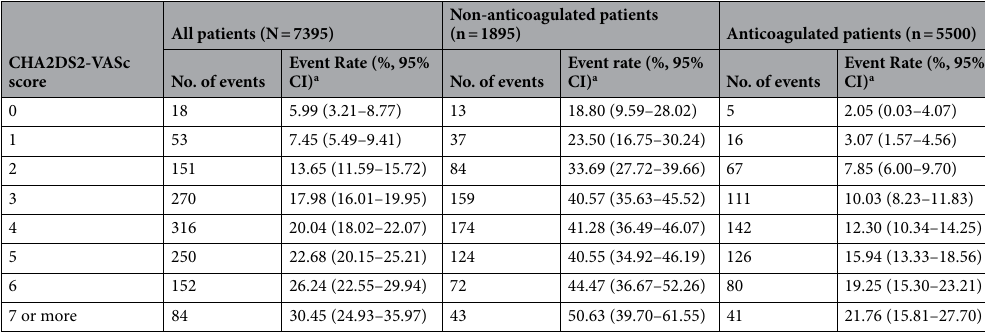
Table 2. Cumulative event rates at 1 year (%) according to the CHA2DS2-VASc scores. All P -values < 0.001 by log-rank test. Event: primary outcome.